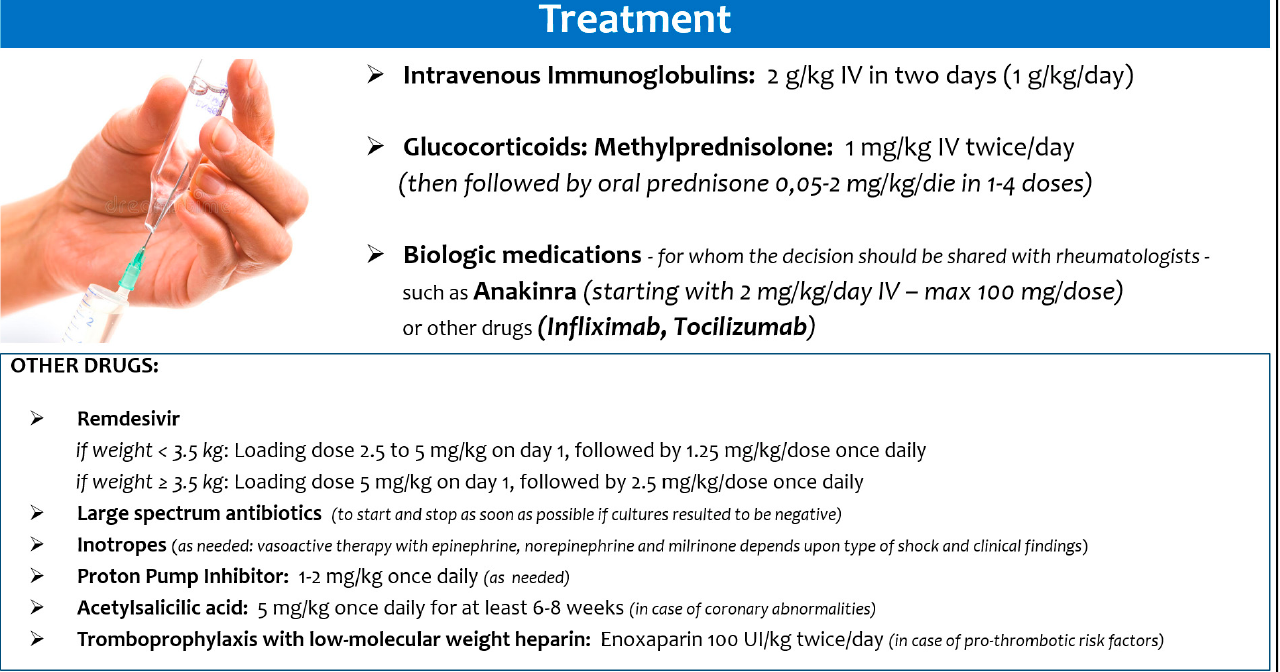
study, the treatment with IVIG and methylprednisolone vs IVIG alone was associated with a more favourable course among children with MIS-C [18,22,45]. However, data in- terpretation is limited by the observational design of the study [75]. Contrarily, antivirals (such as remdesivir) were poorly used (in none of the neonates with MIS-N and only 9.4% of infants with MIS-C) [18,22,45]. Similarly, biologic medica- tions were not given to neonates with MIS-N, whereas about a third of infants with MIS- C required treatment with anakinra, infliximab, tocilizumab, and inhaled interferon α -1b [16,34,36,40,44,45,47]. Most neonates and infants were also treated with large-spectrum antibiotics, given the overlapping clinical signs and symptoms with those of sepsis. Recently, Yock-Corrales and colleagues set the alarm regarding the high rate of antibiotic prescriptions (24.5%) in children with COVID-19 (in particular in those with more severe forms) [76]. Considering the high need for ICU admission in neonates with MIS-N (100%) and infants with MIS-C (40.6%) described in the included studies of this review, and given that an antibiotic treat- ment is often guaranteed in younger infants, the length of antibiotic therapy should be carefully evaluated: reducing patient exposure to large-spectrum antibiotics can result in